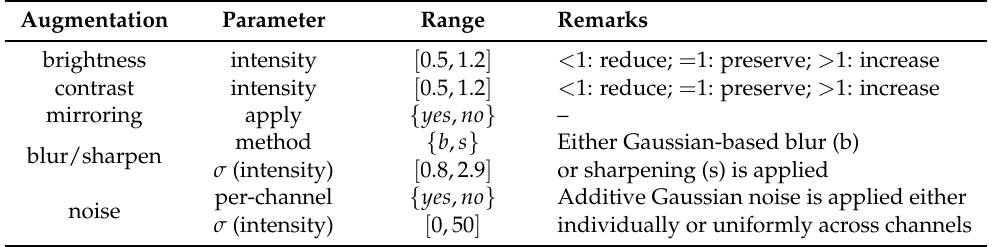
Table A3. Augmentation methods used and their respective parameters. All values are sampled uniformly within their respective ranges in each training